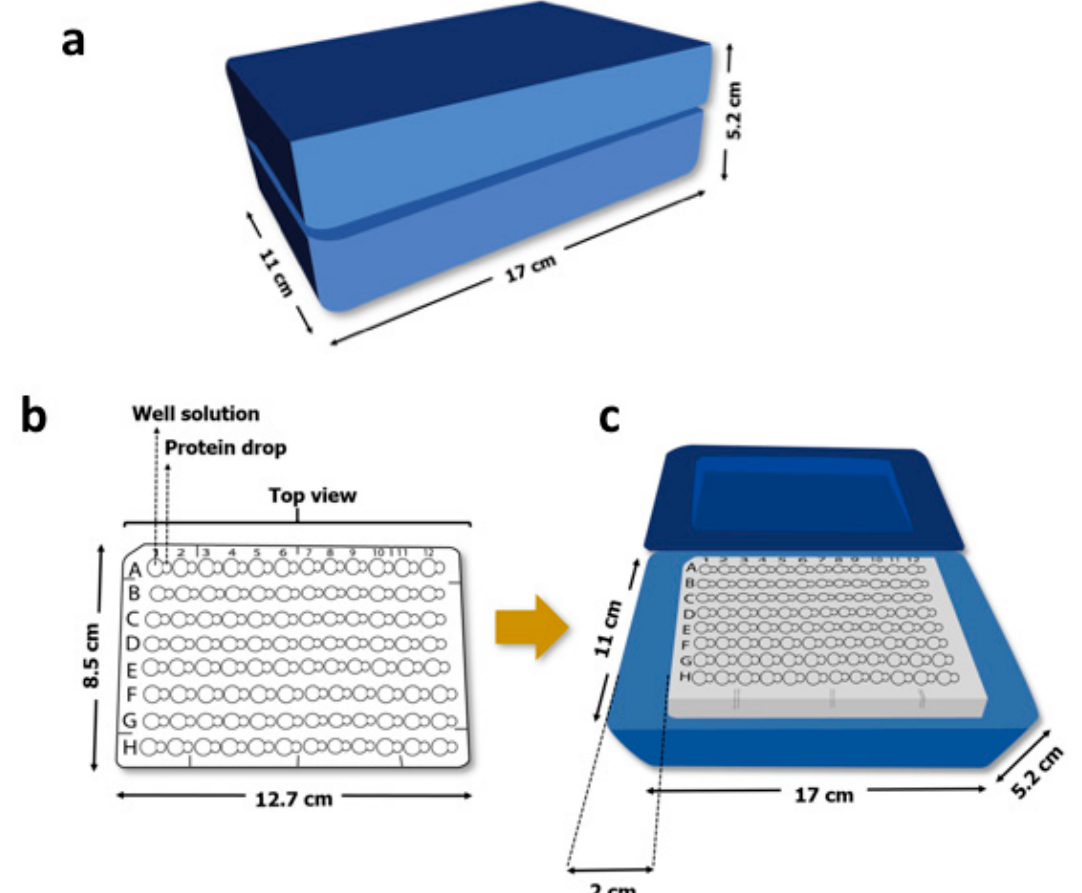
Figure 1. This device can support all types of the conventional plates for vapor diffusion set up in hanging and sitting-drops techniques: ( a ) An overview of the device and dimensions; ( b ) crystallization plate (96 wells) and ( c ) insertion of the crystallization plate.